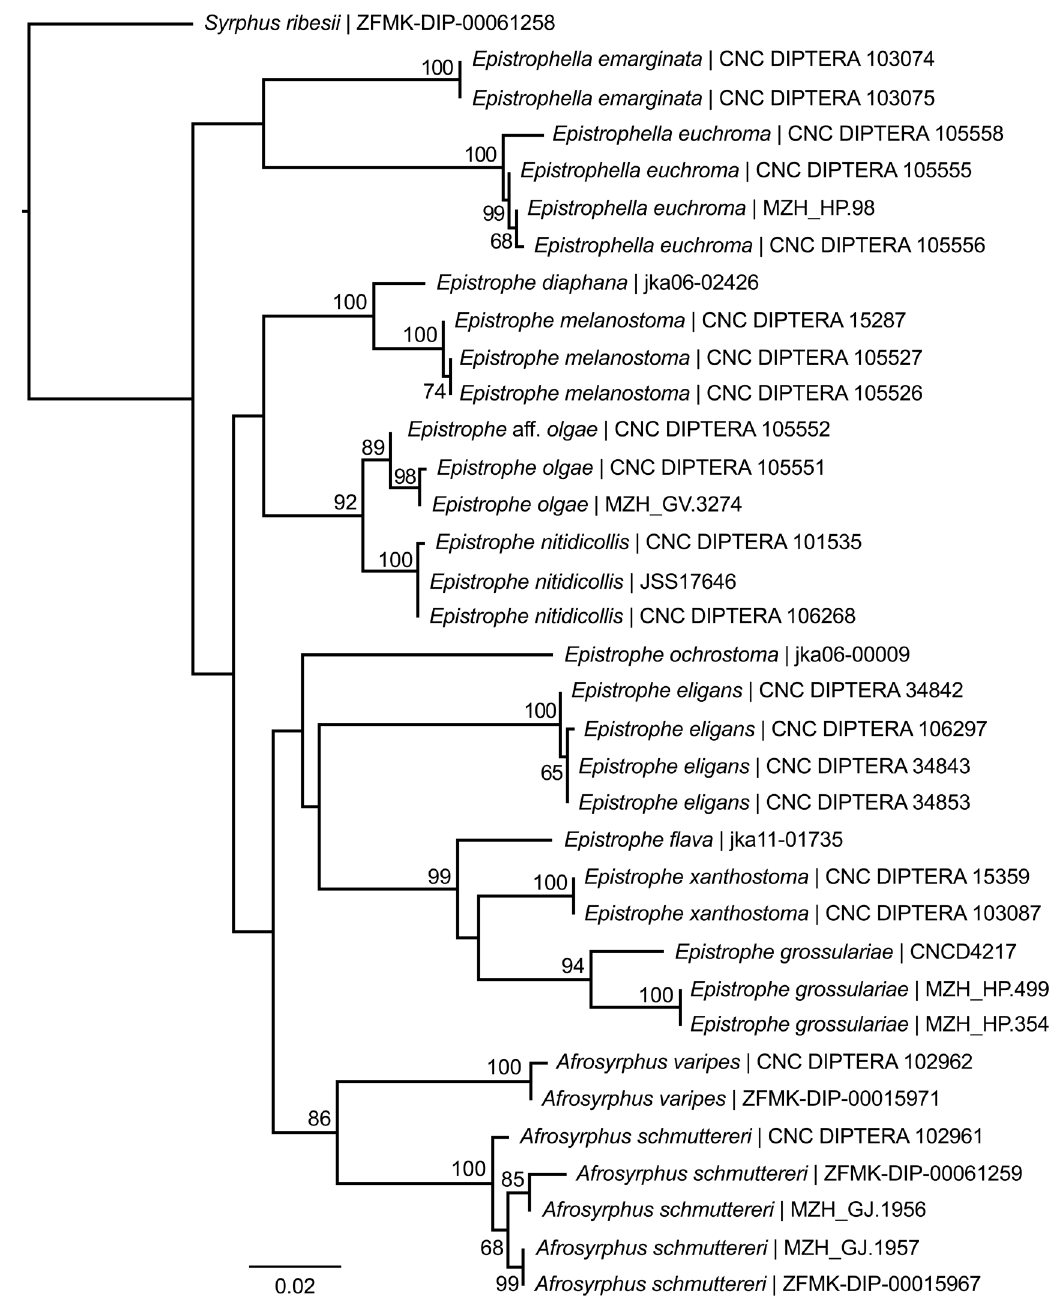
Fig. 6. Maximum-likelihood tree (ln L = -2626.879678) based on COI barcodes, using Garli ver. 2.01. Bootstrap support values are depicted at the nodes (only >